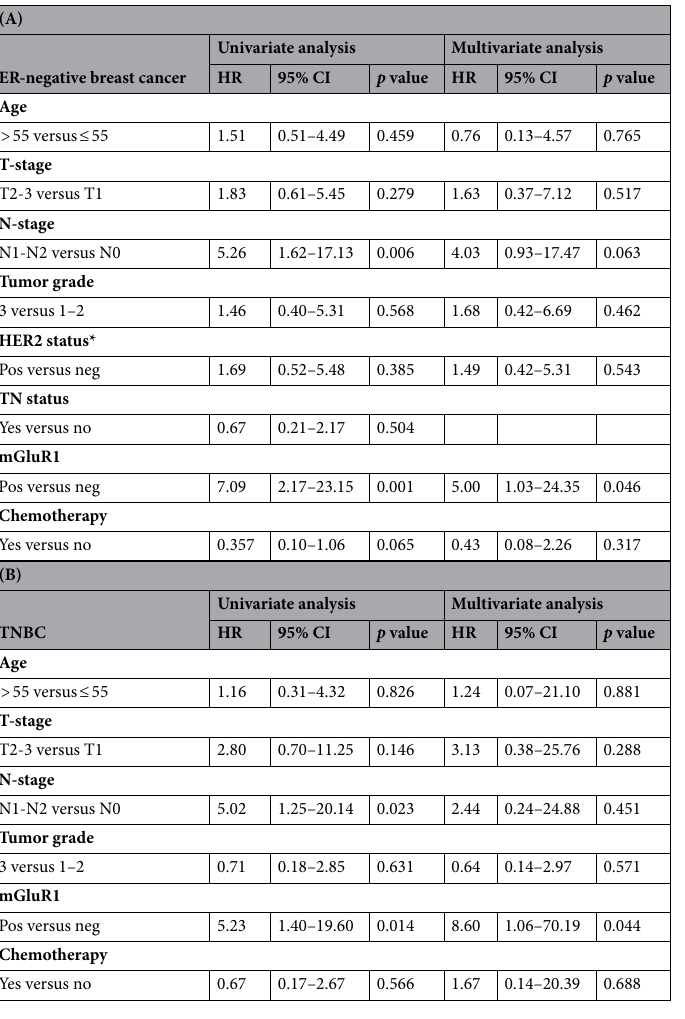
Table 4. Univariate and multivariate analysis of MFS in ER-negative breast cancer and TNBC. *As retrieved from TMA. Univariate and multivariate analysis of MFS in: a ER-negative breast cancer. TN status was excluded in multivariate cox-regression analysis due to correlation with HER2 status; b